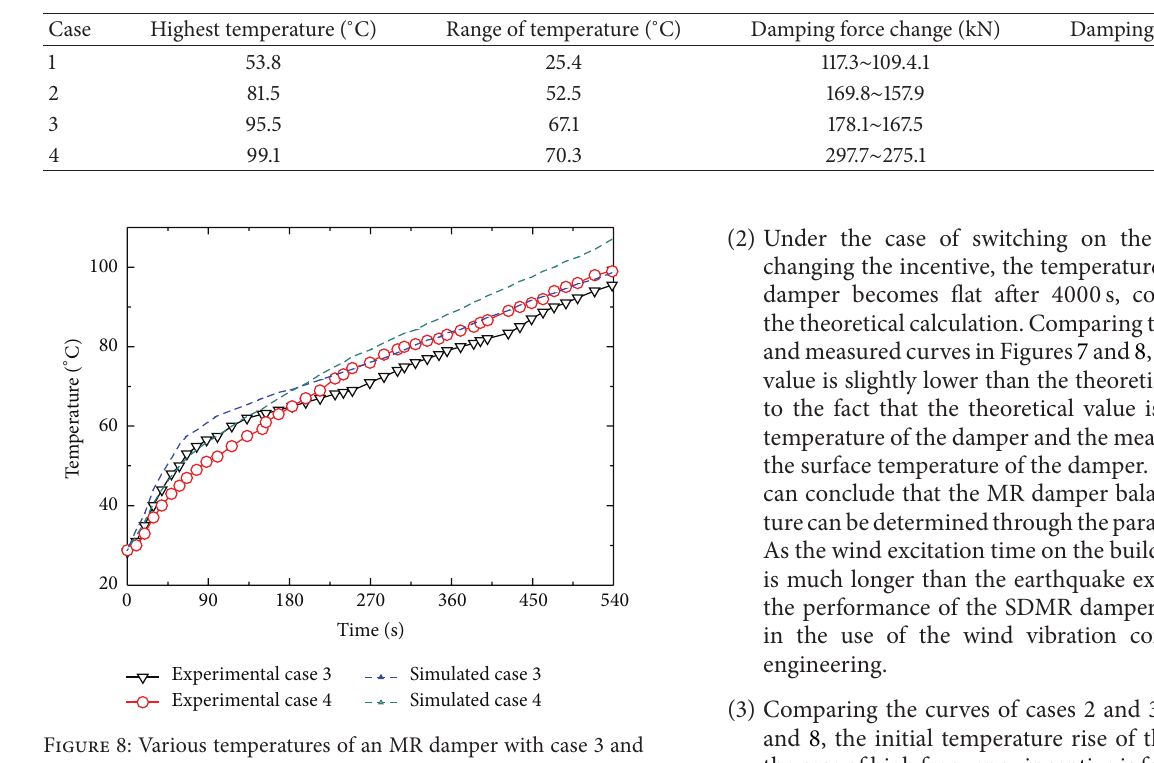
Table 4: Test results of the MR damper characteristics.